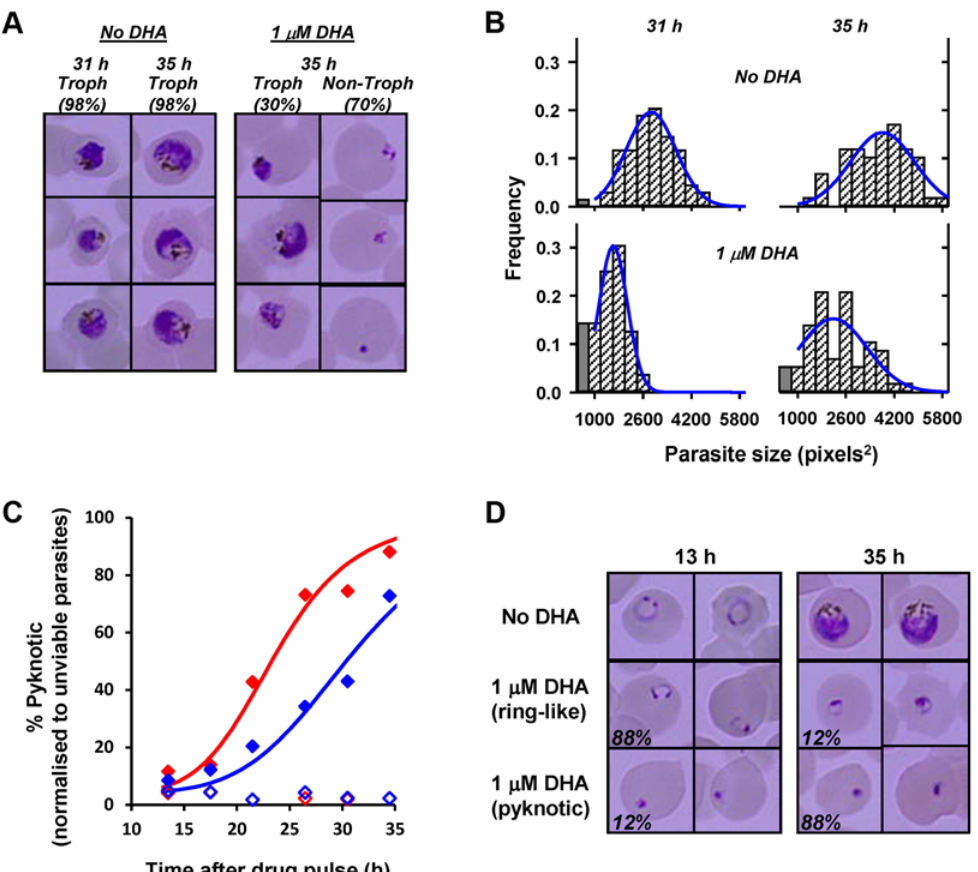
Fig 3. Quantitation of growth retardation and transition to pyknotic forms following DHA treatment. (A) Early ring-stage PL7 parasites (1.5 h p.i.) were treated with a 3.5 h DHA pulse (1 μ M) and the morphology of parasites (Giemsa smears) examined at 31 and 35 h after the drug pulse. Representative images of untreated and treated parasites are shown. The proportion of the parasite population corresponding to trophozoites (hemozoin-containing parasites) and non-trophozoites (rings or pyknotic forms) are indicated in the figure. (B) The size distribution of viable parasites (hemozoin-containing) in the drug-treated culture was quantitated and compared with untreated cultures at the indicated times after the drug pulse ( n > 50 per sample). Late rings are larger than early trophozoites and were counted as a separate category (filled grey bars). (C) PL2 (red) and PL7 (blue) parasites (1.5 h p.i.) were rendered unviable by treatment with a DHA pulse (1 μ M, 3.5 h) and the fraction of unviable parasites exhibiting pyknotic morphology was quantitated (filled symbols). Open symbols denote untreated parasites. (D) Representative images of untreated PL2 parasites and treated unviable parasites showing ring-like and pyknotic morphologies (fraction of each morphology